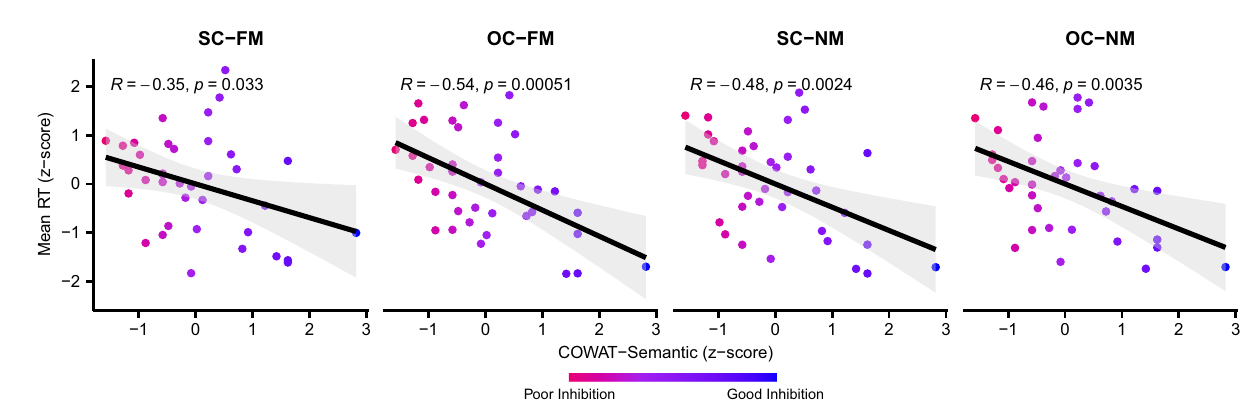
Figure 2. Significant correlations between RTs of the metaphor comprehension task and the scores of COWAT- Semantic. The x-axis indicates the scores of COWAT-Semantic and the y-axis denotes participants’ RTs. Both values were converted to z-scores. Each dot represents an individual’s data, and colors of the dots imply each participant’s level of competence in inhibition. The error bands indicate 95% confidence intervals. There was a tendency for the individuals with good inhibition capabilities (i.e., higher scores in the COWAT-Semantic) to respond faster to metaphor comprehension task in all the conditions compared to individuals with poor inhibition capabilities (i.e., lower scores in the COWAT-Semantic). SC–FM supporting context with familiar metaphor, OC–FM opposing context with familiar metaphor, SC–NM supporting context with novel metaphor, OC–NM opposing context with novel metaphor, COWAT controlled oral word association